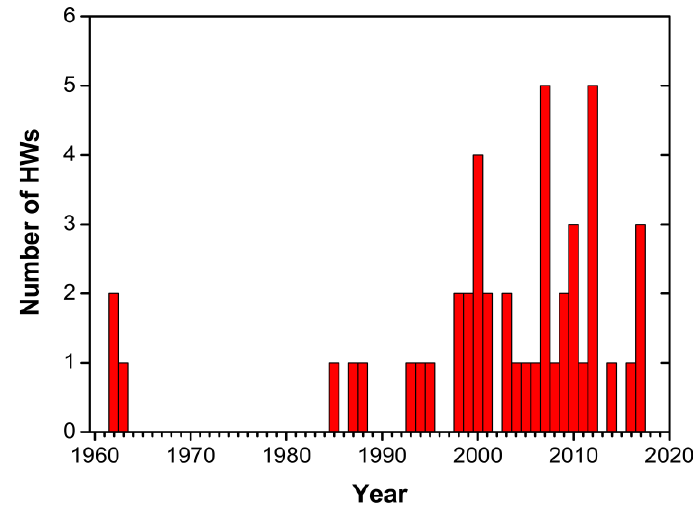
Figure 2. Number of heat waves (HWs) per year over the 1960 – 2017 period.